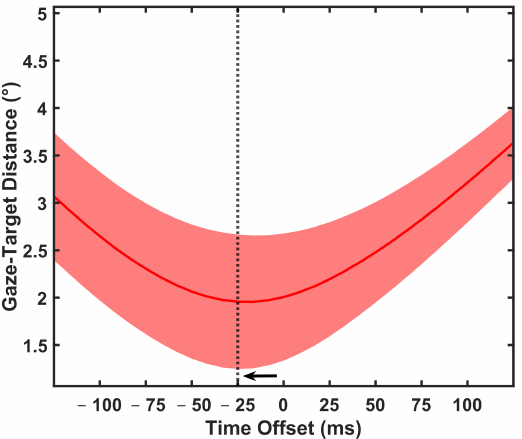
Figure 4. Latency offset for best gaze-target distance across all subjects. The red line indicates the mean tested for all the different time offsets, and the shading red represented the SD around the mean. The black arrow indicates that the best gaze-target distance is at its lowest when gaze data are sifted by 25ms.